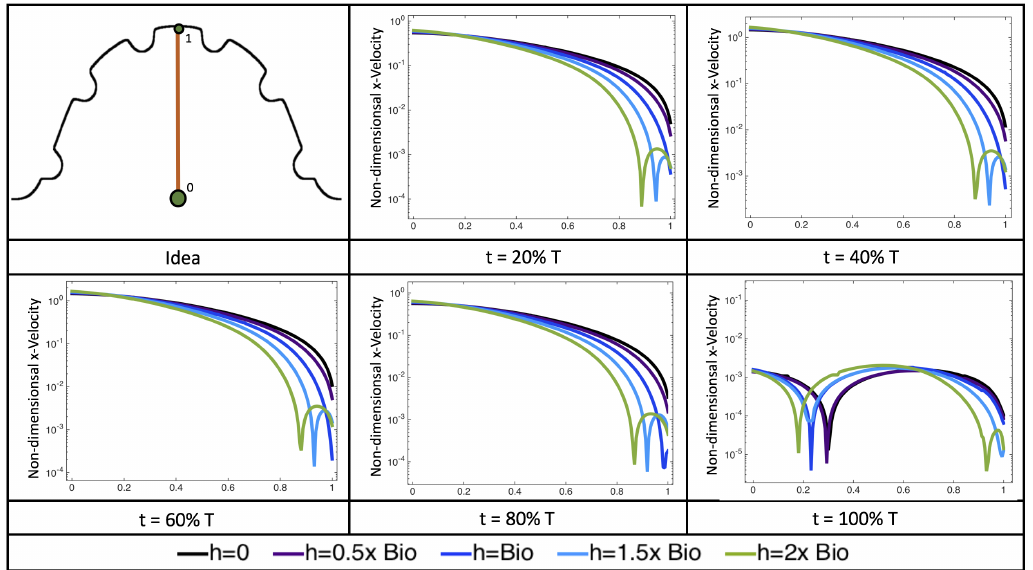
Figure 22. Snapshots during a pulsation cycle in the Re = 1 case of the horizontal velocity measured from the intracardial center (labeled “0”) to the intertrabecular region (labeled “1”) directly above for multiple trabeculae heights. The trabeculae cause a drop in velocity as one nears the ventricular wall. Each sub-figure corresponds to a different time point described as percentge of the pulsation cycle, T . Figure 23 shows streamline plots for Re = 10 at ten evenly spaced times during a pulse. Intertrabecular vortices form during the first half of the pulse if the dimensionless trabecular height is at least 0.04. For all geometries, intracardial vortices form during the last half of the pulse. The formation of the intracardial vortex annihilates the intertrabecular vortices, at least initially. The intracardial vortices form on the upstream side of the chamber, and grow to fill the entire chamber by the end of = 0.12, 0.16. the pulse. The intertrabecular vortices form again towards the end of the pulse for h T b V Note that the presence of the intracardial vortex causes the intertrabecular vortices to change direction so that they spin clockwise (and the intracardial vortices spin